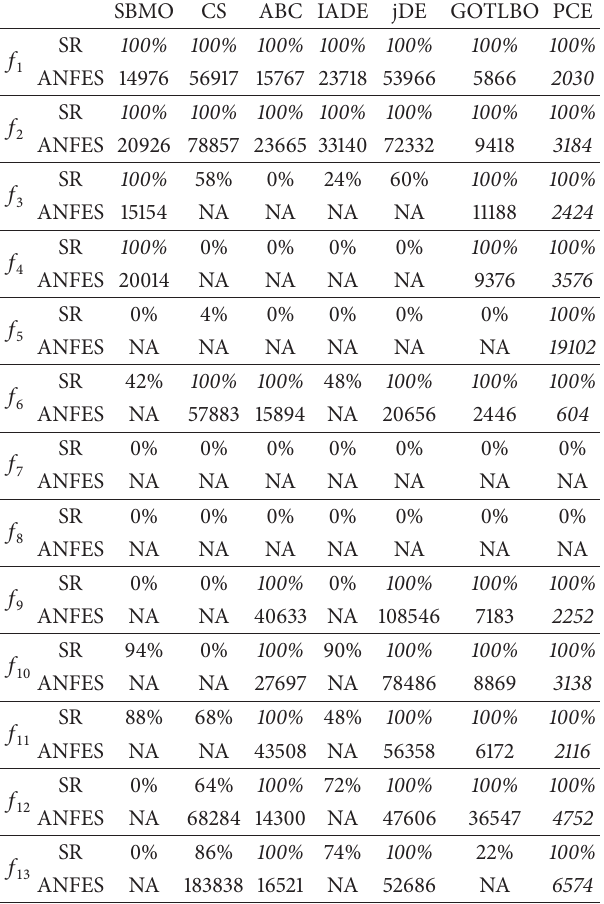
Table 5: The SR and ANFES